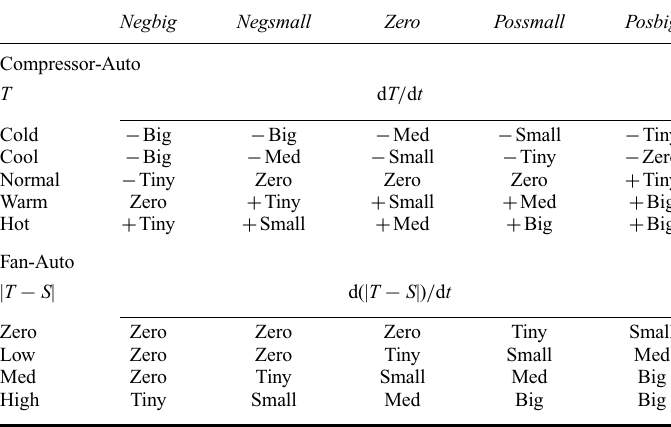
TABLE II Rule Bases for Compressor and Fan